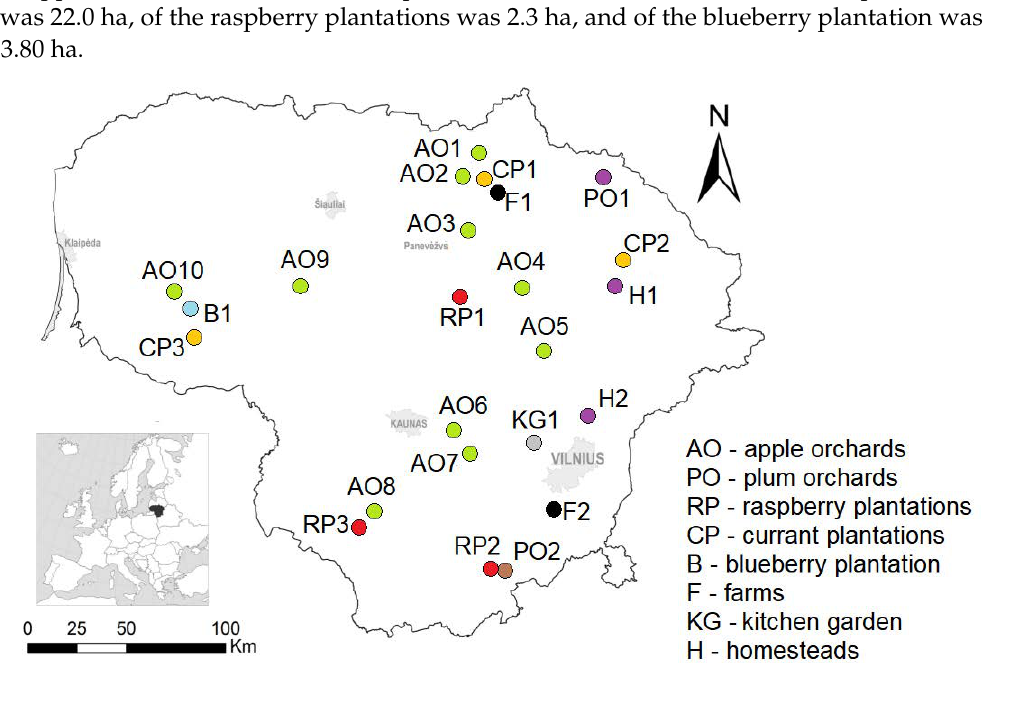
Figure 1. Study sites in Lithuania,